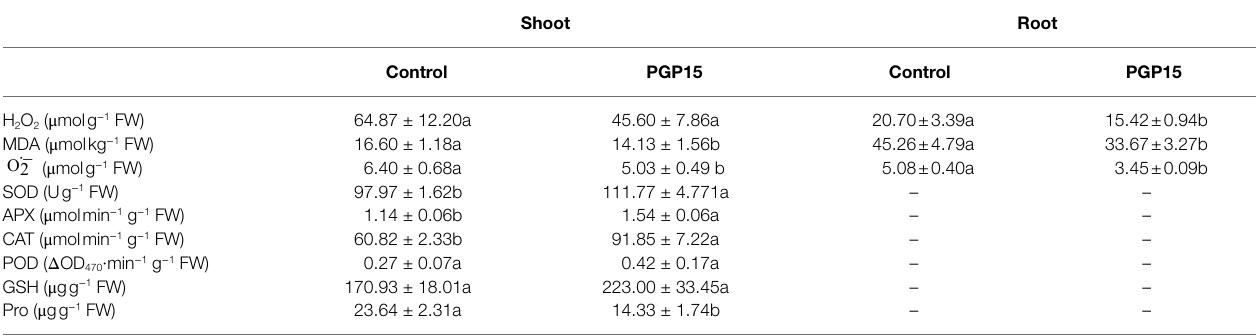
TABLE 2 | The effects of Cd treatment on H 2 O 2 , malondialdehyde (MDA), and O · 2 − concentrations in shoots and roots and the enzymatic (SOD, APX, CAT, and POD) and non-enzymatic antioxidants (GSH and Pro) in shoots of S. nigrum